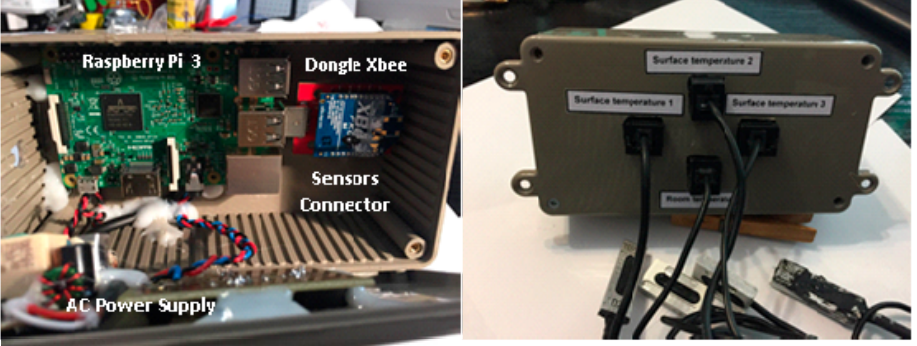
Figure 4. Master + indoor module prototype: Internal ( left ) and external ( right ) views, with its four temperature sensors.